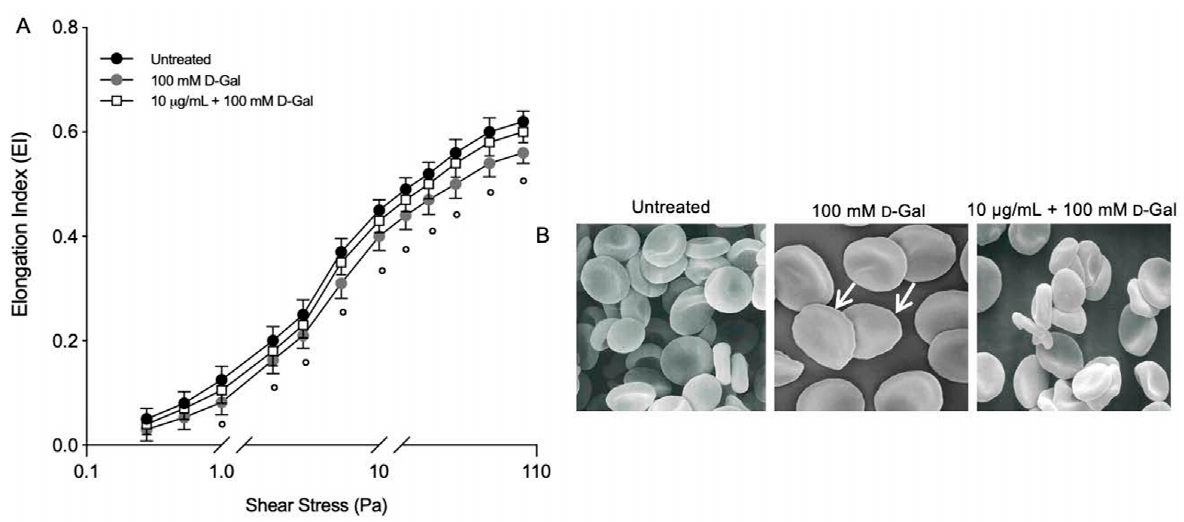
Figure 4. ( A ) Elongation index (EI) at different shear stress values (Pa). Red blood cells were exposed to 100 mM D -Gal for 24 h, with or without pre-incubation with 10 µ g/mL Aça ì extract for 1 h. ◦ = p < 0.05 versus 100 mM D -Gal; n = 3. ( B ) Evaluation of RBC morphology. Representative images obtained using scanning electron microscopy show RBCs with normal biconcave form (control) and with flattened shape (leptocytes, arrows) (100 mM D -Gal). Aça ì extract (10 µ g/mL) pre-incubation attenuated the shape changes compared to 100 mM D -Gal treatment. Magnification 3000 × . Images reported from reference cited above.